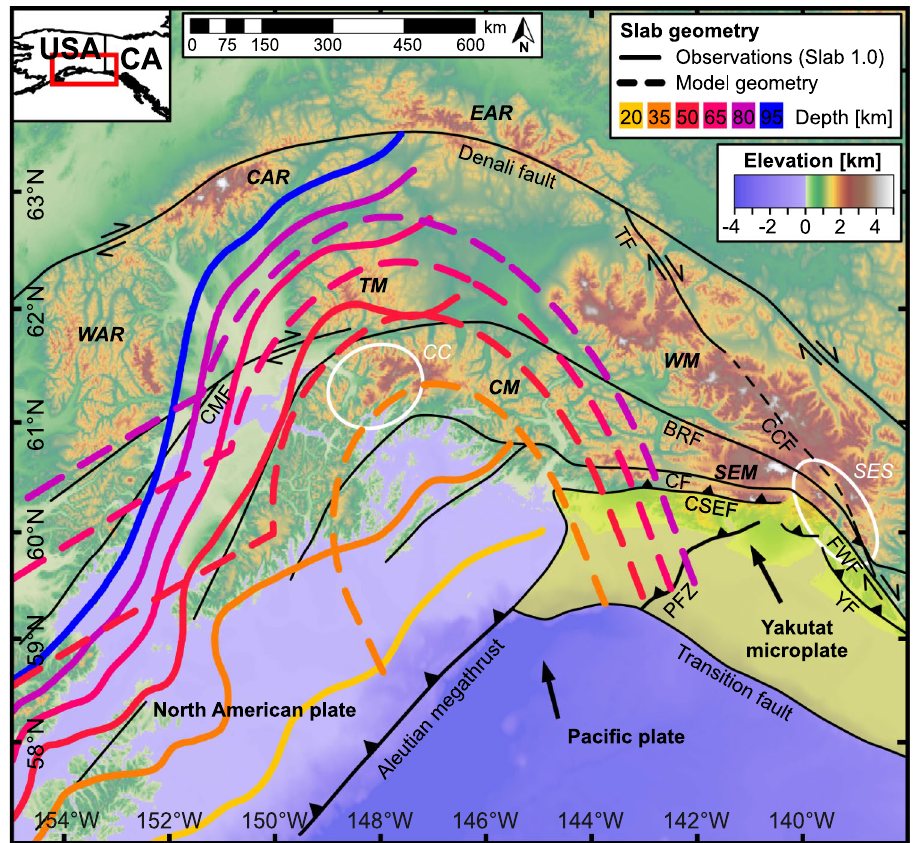
Figure 1. Tectonic overview of the southern Alaskan plate corner. Major faults 35,36 are shown as black lines: BRF—Border Ranges fault, CCF—Connector fault, CF—Contact fault, CMF—Castle Mountain fault, CSEF— Chugach-St. Elias fault, FWF—Fairweather fault, PFZ—Pamplona fault zone, TF—Totschunda fault, YF— Yakutat fault. Mountain ranges are marked with bold, italic letters: CAR—Central Alaska Range, CM—Chugach Mountains, EAR—Eastern Alaska Range, SEM—St. Elias Mountains, TM—Talkeetna Mountains, WAR— Western Alaska Range, WM—Wrangell Mountains. White ellipses: CC—Chugach Core, SES—St. Elias syntaxis. Two bold arrows indicate the direction of Pacific and Yakutat plate motion. The solid colored lines indicate the depth contours corresponding to the observed configuration of the subducting interface from the global 3D model of subduction zones geometry (Slab 1.0; ref. 26 ). The dashed lines show the approximated geometry of